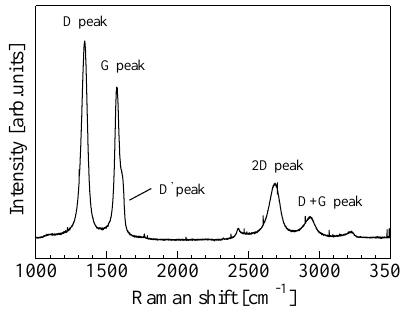
Figure 2. Raman spectra of CNWs.